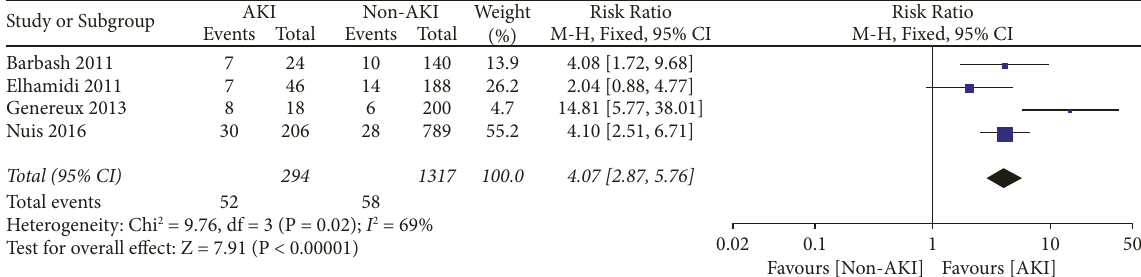
Figure 5: Meta-analysis of 30-day all-cause mortality in AKI versus non-AKI patients after